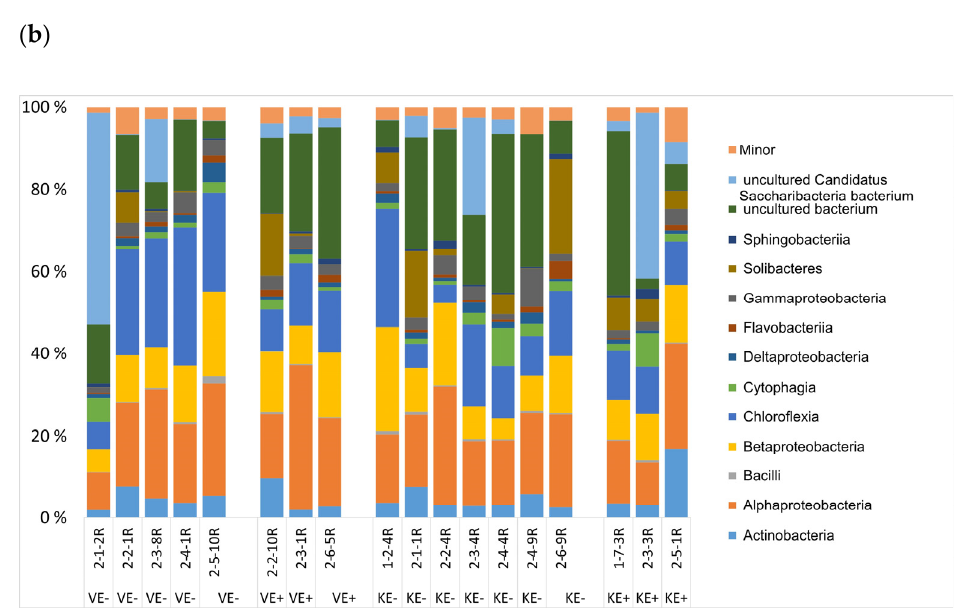
Figure 6. Taxonomic distribution of bacterial communities at the phyla level in the ( a ) leaves and